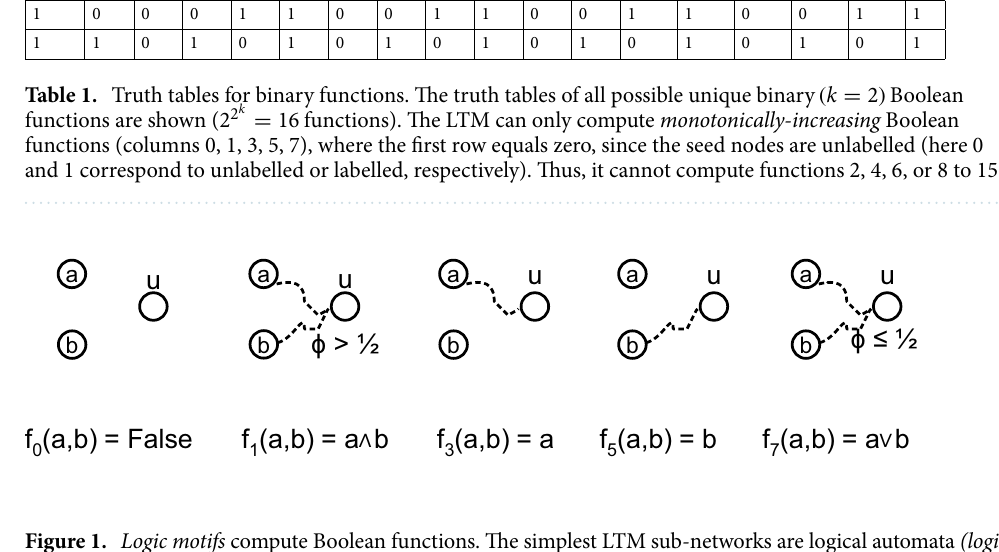
Figure 1. Logic motifs compute Boolean functions. The simplest LTM sub-networks are logical automata (logic motifs) and compute the monotone functions for k = 2 inputs at node u on perturbations of a and b . Dashed lines are network